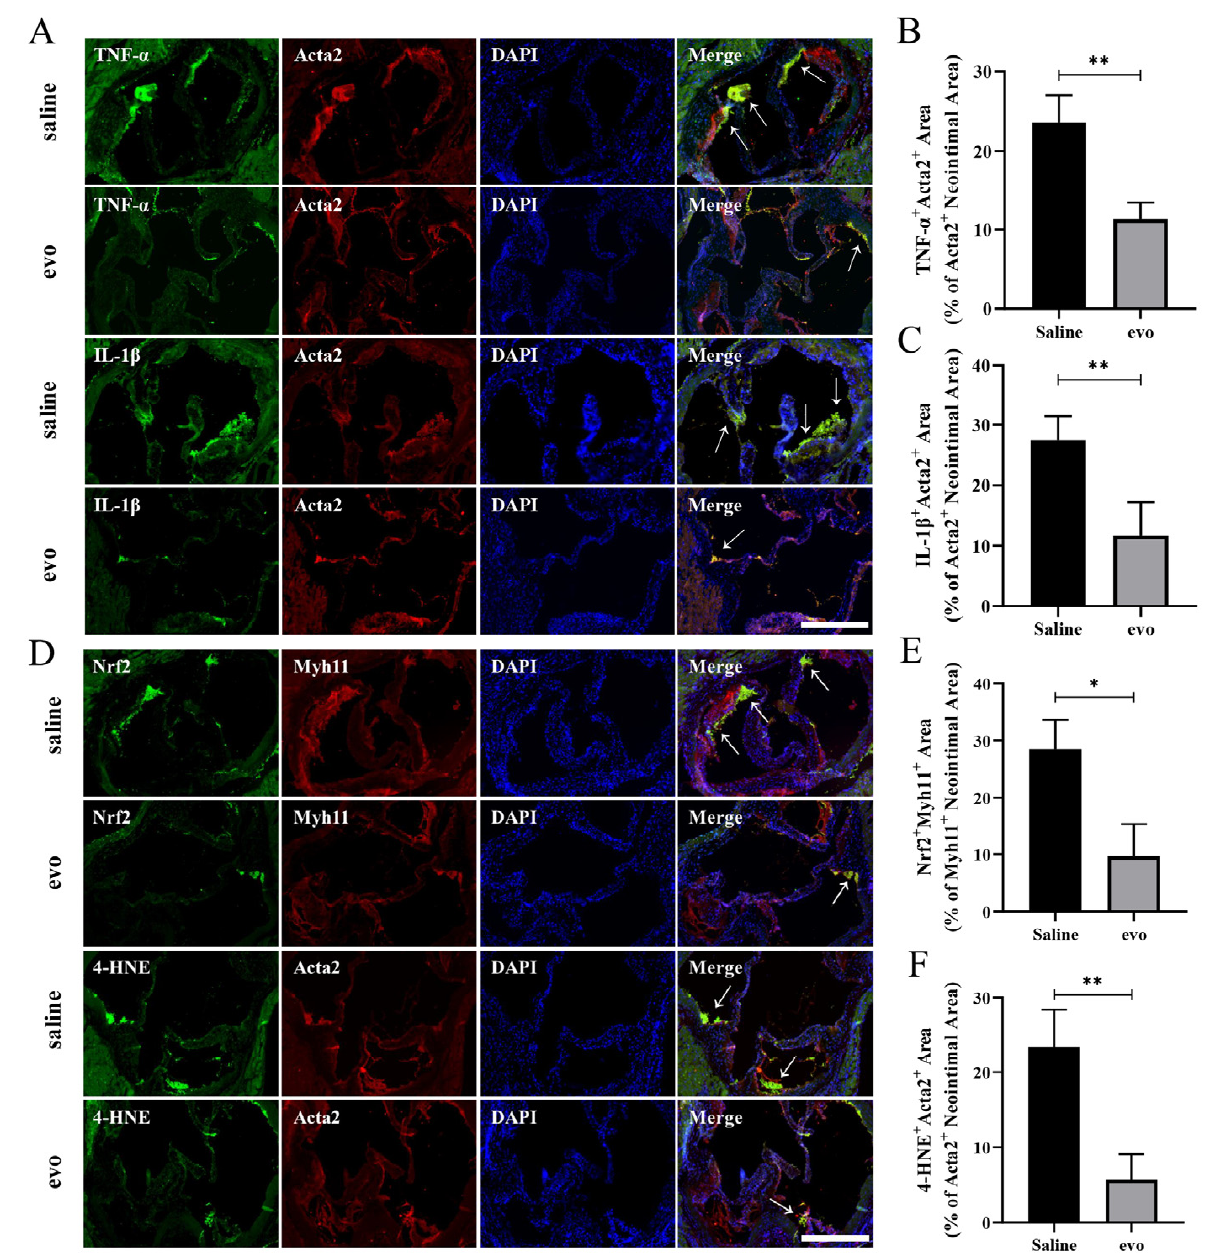
Figure 4. Analysis of inflammatory response and oxidative stress levels of atherosclerotic VSMCs in mice: ( A – C ) the transverse section of the aortic root was analyzed and quantified by immunofluorescence staining. TNF- α and IL-1 β expression in atherosclerotic plaques (green). Immunofluorescence shows that Acta2 (red) co-expresses TNF- α and IL-1 β within the atherosclerotic lesion. The white arrow points to the co-stained area. Scale bar 500 µ m. ( D – F ) Nrf2 and 4-HNE expression in atherosclerotic plaques (green). Immunofluorescence shows that Myh11 (red) co-expresses Nrf2 and Acta2 (red) co-expresses 4-HNE within the atherosclerotic lesion. The white arrow points to the co-stained area. Scale bar 500 µ m. The bar graphs depict means ± SEM; statistical significance * p < 0.05 and ** p < 0.01 by the one-way ANOVA test.